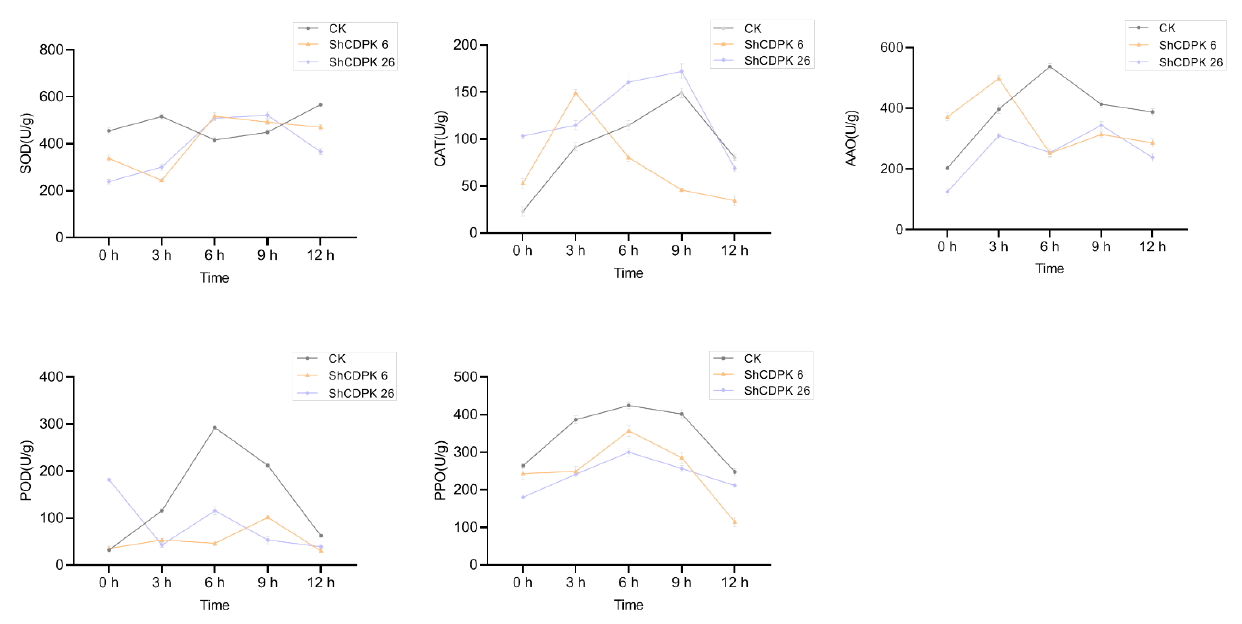
Figure 7. Determination of physiological indexes of ShCDPK6 and ShCDPK26 silenced plants and control plants under cold stress. Activity of SOD, CAT, AAO, POD, PPO. Each value is the mean ± standard deviation of at least three independent measurements.